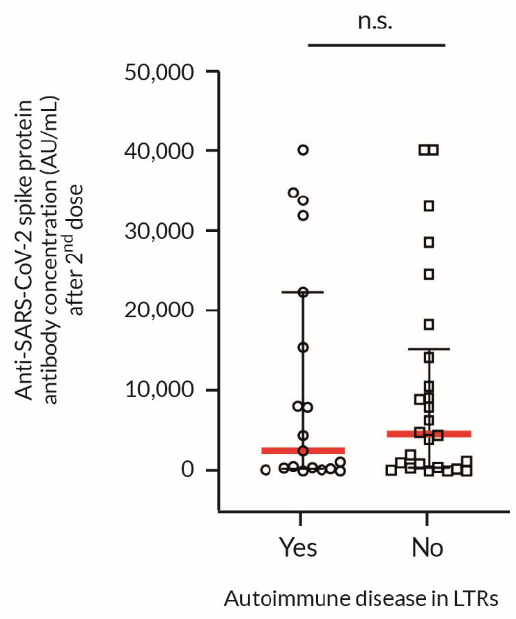
Figure 4. Anti-SARS-CoV-2 spike protein Ab concentration after the second dose in response to BNT162b2 vaccination in LTRs with autoimmune or non-autoimmune etiology of liver transplantation. Post-vaccination antibodies production in LTRs with autoimmune (autoimmune hepatitis, primary biliary cirrhosis or primary sclerosing cholangitis) and non-autoimmune causes of liver transplantation. Values are presented as the scatter-dot plot with median (middle line), lower (25%), and upper (75%) quartile (as whiskers); the p -value was calculated with the non-parametric Mann–Whitney U Test. 2nd dose = 4–8 weeks after the second dose of vaccination; BNT162b2 = BioNTech/Pfizer COVID-19 mRNA vaccine; LTRs = liver transplant recipients; n.s. = not significant.